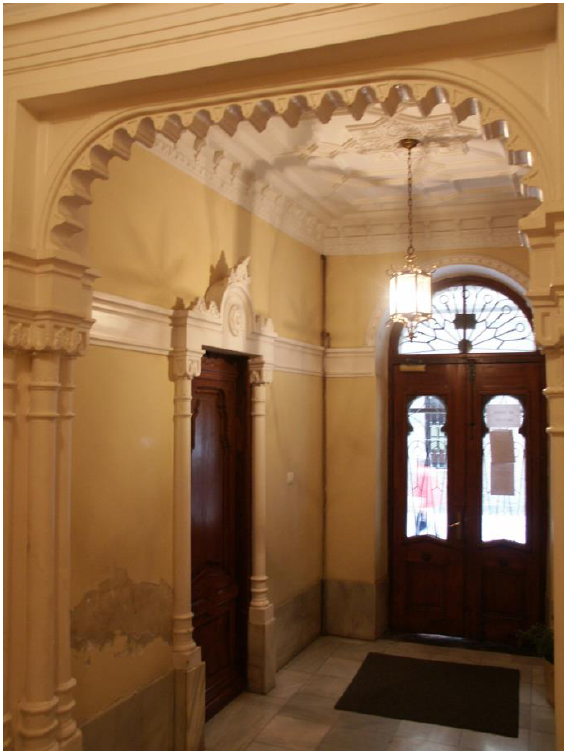
Figure 2. Entrance hall of the building of Modesto Echaniz and Lino Garay (1881). Bilbao. Photo took by María Teresa Paliza Monduate.